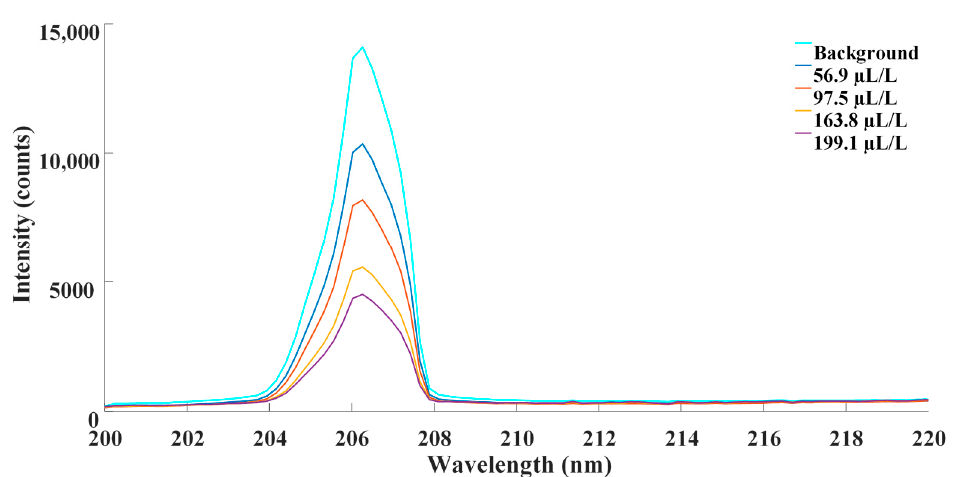
Figure 4. Absorption spectra of transmission at different concentration of SO 2.